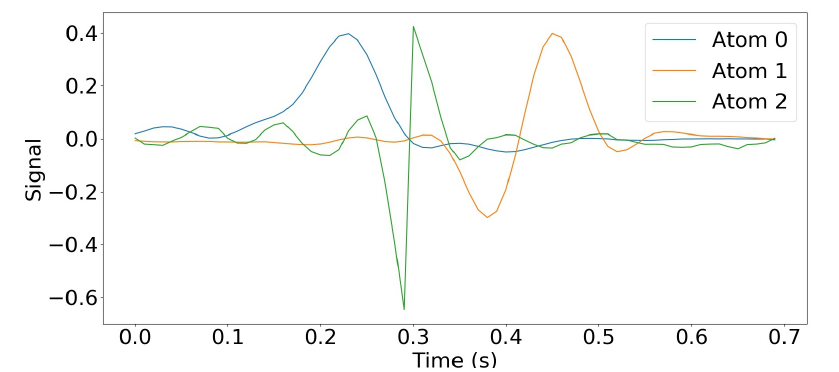
Figure 4. Dictionary learned using Equation (2). The amplitude of the atoms is small compared to the signal because they are normalized.